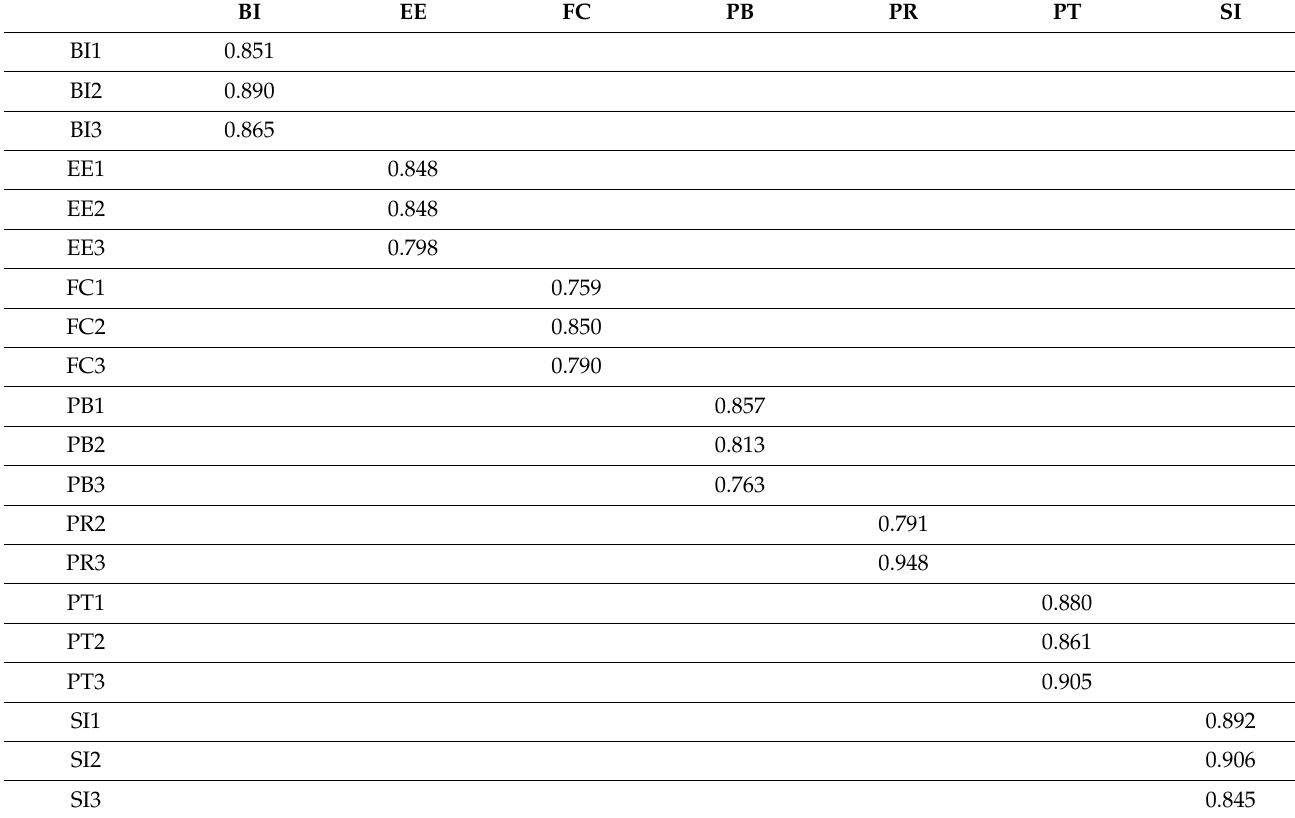
Table 2. Outer loadings values of the measurement construct.